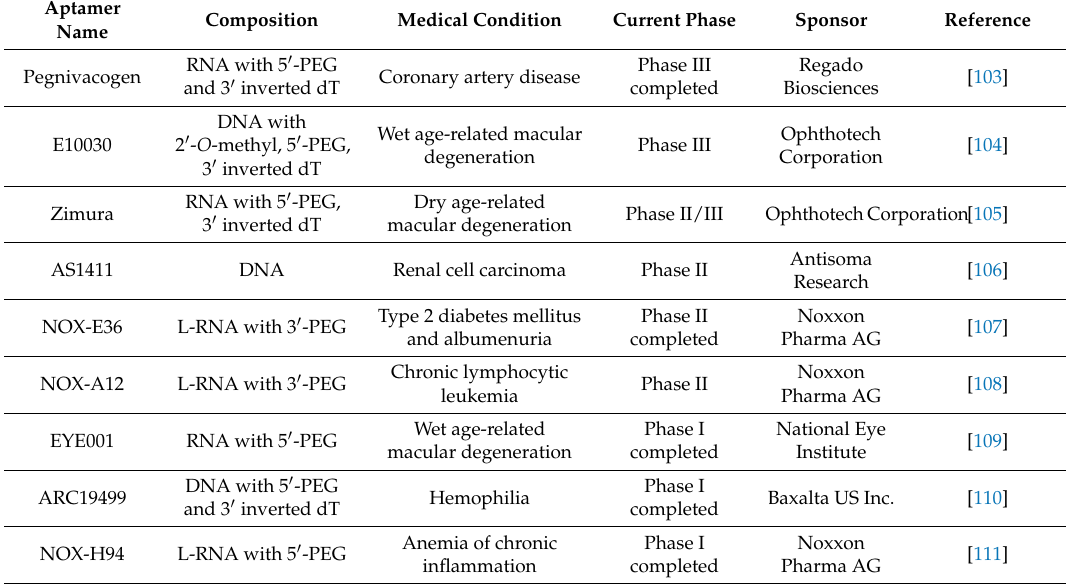
Table 1. Aptamers in clinical